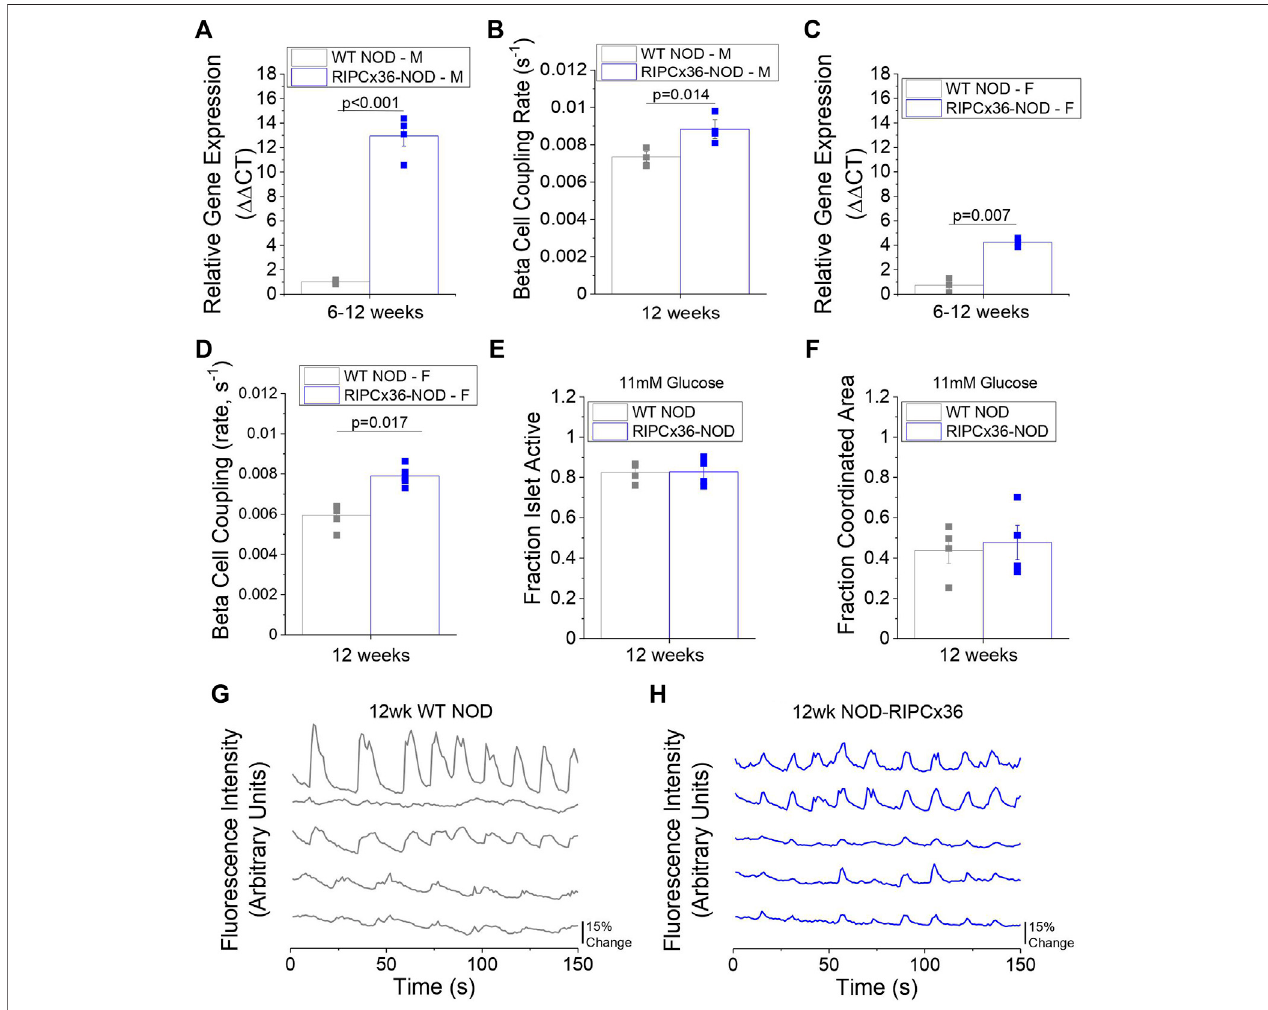
FIGURE 5 | Overexpression of Cx36 in the NOD mouse. (A) Gene expression of Cx36 in 8 – 12-week old male WT NOD and RIPCx36-NOD mice normalized to HPRT1 housekeeping gene using the ΔΔ Ct method ( n = 4). (B) β -cell coupling as measured by fl uorescence recovery rate in isolated islets from 12-week old male WT NOD (grey) and RIPCx36-NOD (blue) mice ( n = 4). (C) Gene expression of Cx36 in 12-week old female WT NOD and RIPCx36-NOD mice normalized to HPRT1 housekeeping gene using the ΔΔ Ct method ( n = 3). (D) β -cell coupling as measured by fl uorescence intensity recovery rate in isolated islets from WT NOD and RIPCx36-NOD mice ( n = 4 – 5). Quanti fi cation of the fraction of the islet area showing intracellular Ca 2+ activity (E) and the fraction of the islet area with coordinated Ca 2+ oscillations (F) at 11 mM glucose in isolated islets from 12 week old WT NOD and RIPCx36-NOD mice ( n = 3 – 4). Representative plots of intracellular Ca 2+ as measured by fl uorescenceintensityat11 mMglucosein5individualcellsinthesameisletovertimein12-weekold (G) WTNOD(grey)and (H) RIPCx36-NOD(blue)mice.Datafrom individualmicearerepresentedbygreyorbluesquaresforWTNODorRIPCx36-NODmicerespectively.DatainA-Frepresentthemean±SEM. p < 0.05issigni fi cantas determined by t-test in A-F. All animals are female unless otherwise